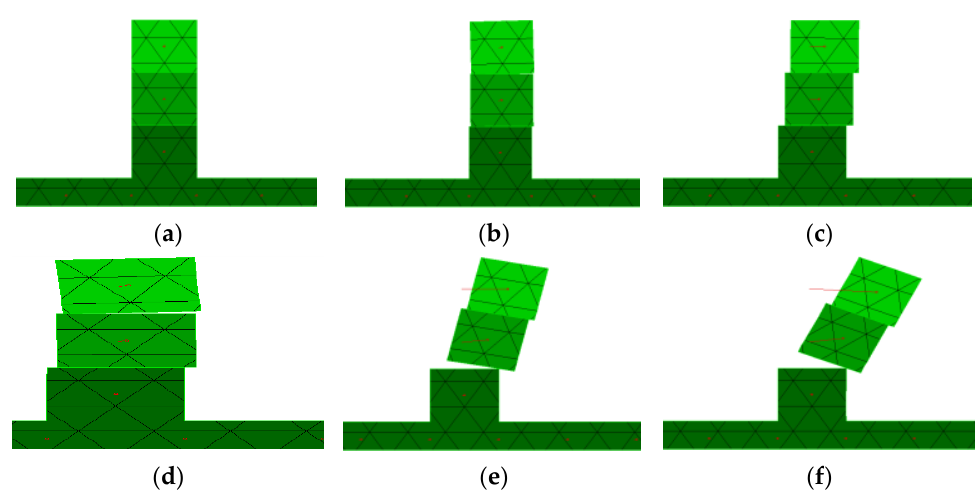
Figure 19. Simulated results of the model using the G- α 0 method. ( a ) 4.35 s; ( b ) 6.44 s; ( c ) 7.32 s; ( d )